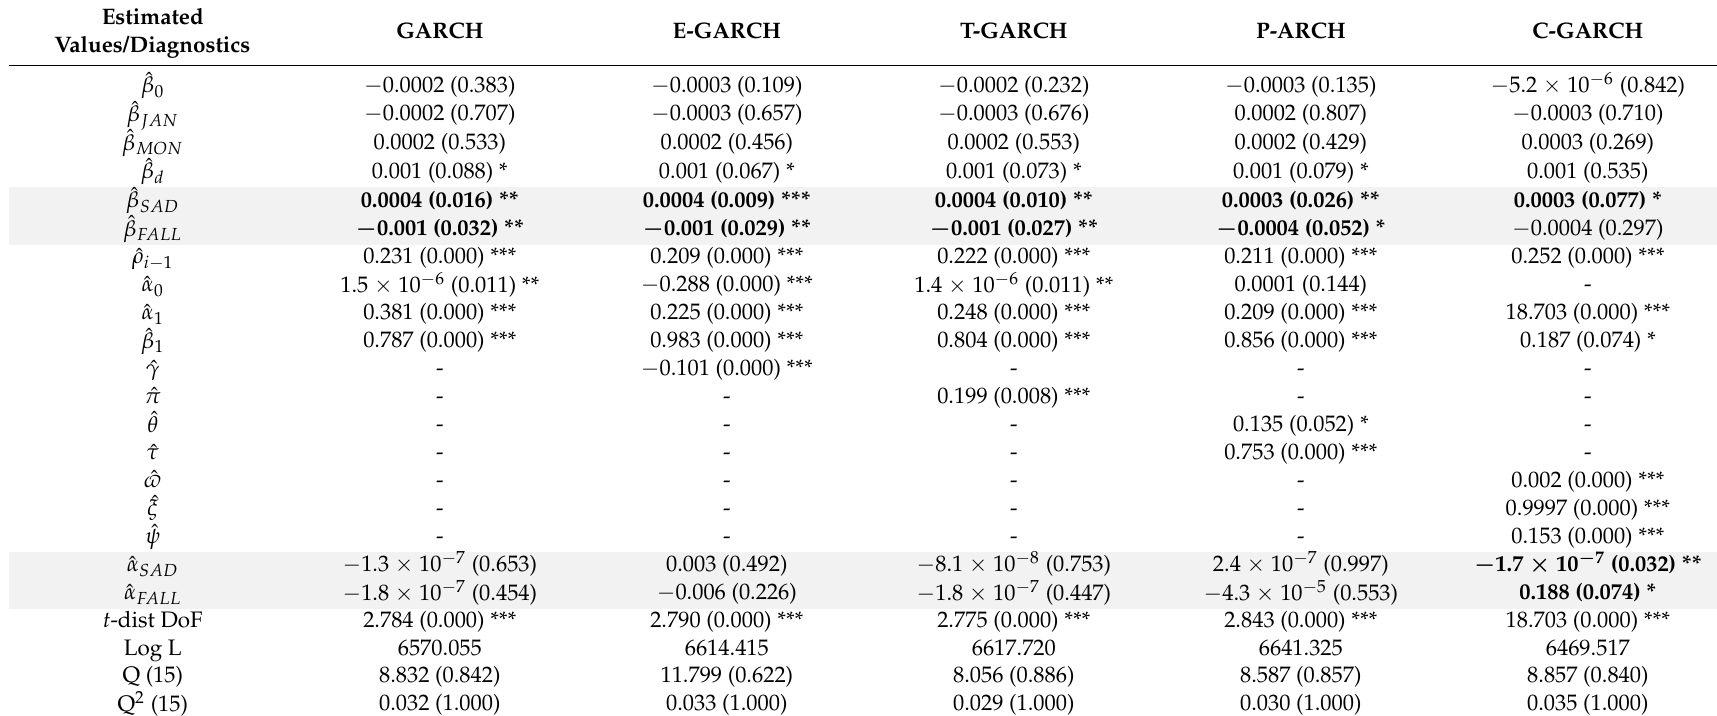
Table A10. Different GARCH specifications for